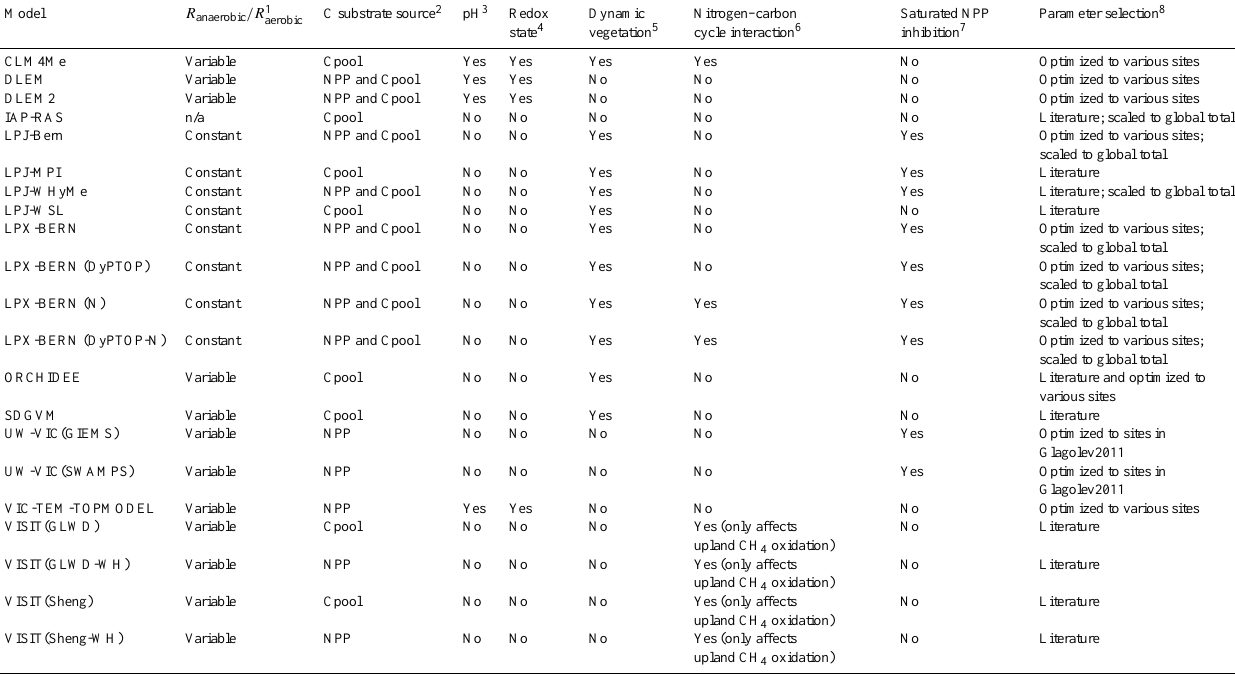
Table 3. Participating models and their relevant biogeochemical features.